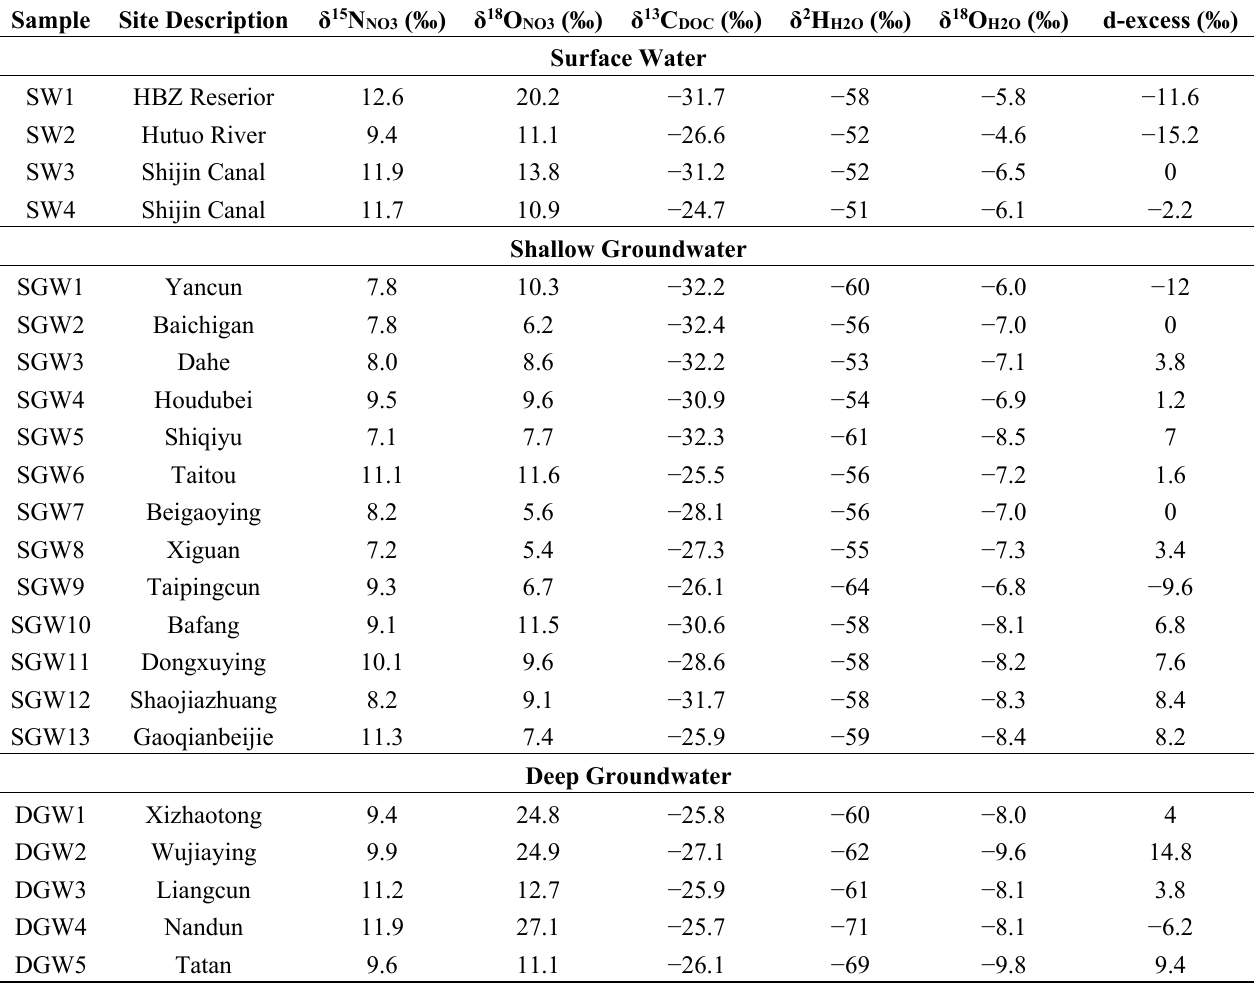
Table 2. Environmental isotopes data of the field